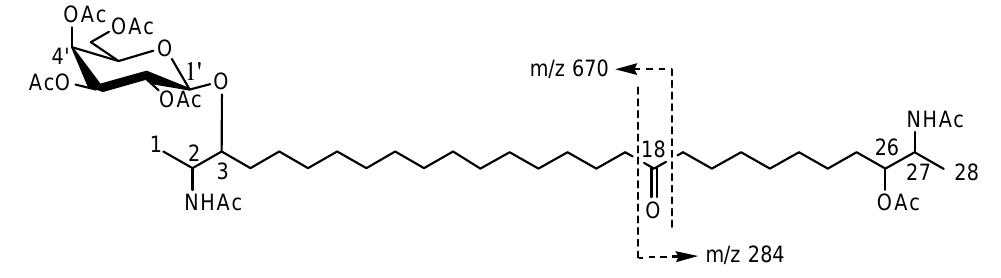
Figure 2 . MS Fragmentation of rhizochalin peracetate 1